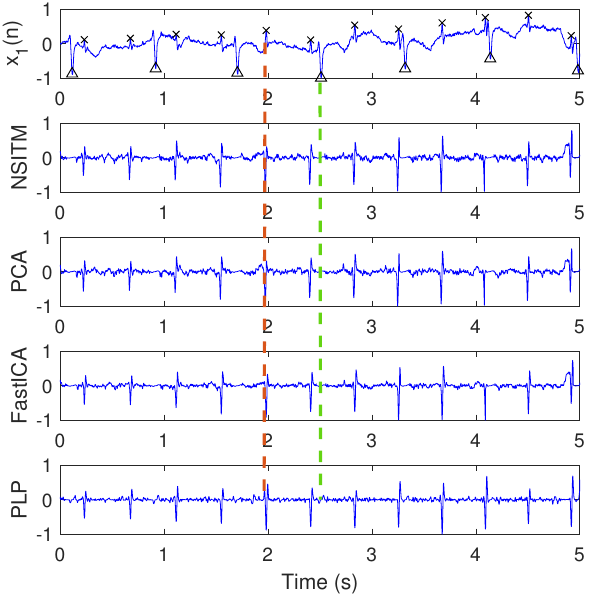
Figure 12. Clean extracted FECG signals (signals 2, 3, 4, and 5, from the top) of Figure 10 after the removal of MECG signals by ACF, and based on R peaks locations in Figure 11. The first signal from the top, x 1 ( n ) , is the abdominal signal taken from Figure 9, and used as a reference of marking the FECG and MECG R peaks. The ’x’ and ’ ∆ ’ markers refer to the reference positions of the R peaks in FECG and MECG signals, respectively. The red dashed lines refers to one position of the extracted FECG R peaks. The green dashed lines refers to one position of the removed MECG R peaks. The y -axis labels of signals 2, 3, and 4 (from the top) refer to the names of the algorithms used for extracting the FECG signals. The data used are from the Physionet Challenge 2013 data set a, file